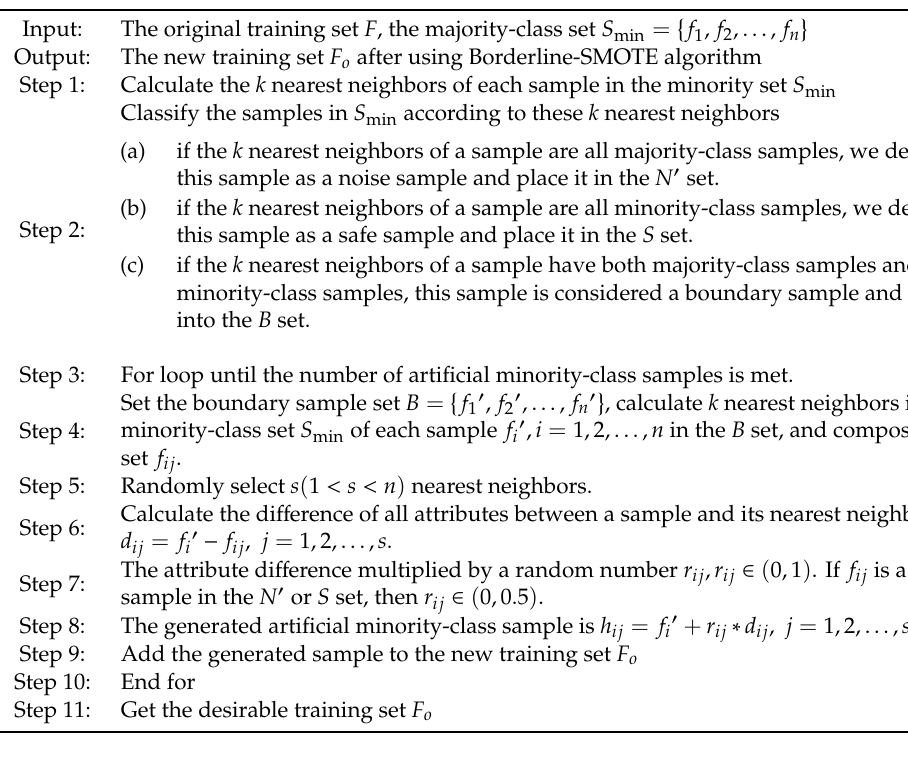
Table 6. The implementation flow of the